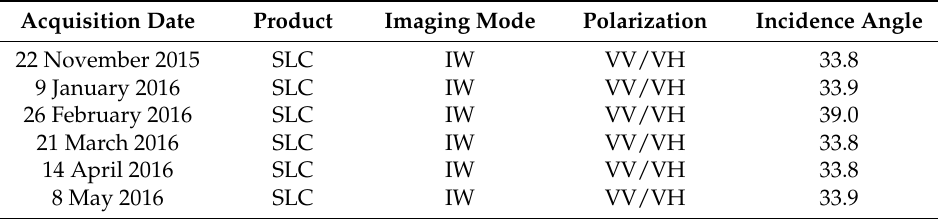
Table 1. Main characteristics of Sentinel-1A images used in this study.